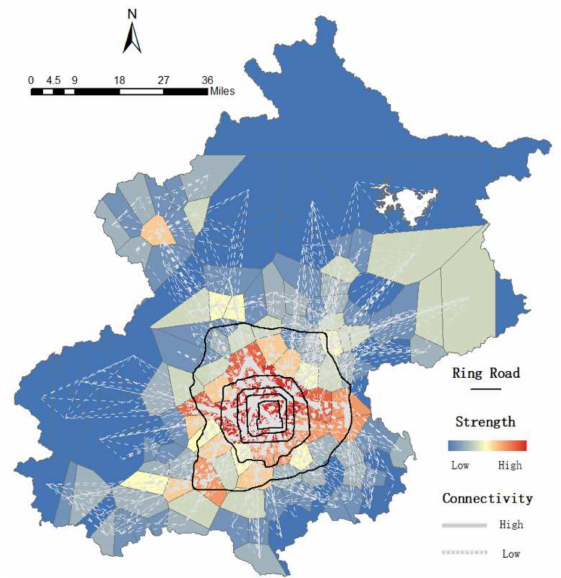
Figure 9. Connectivity and strength in Voronoi diagram.